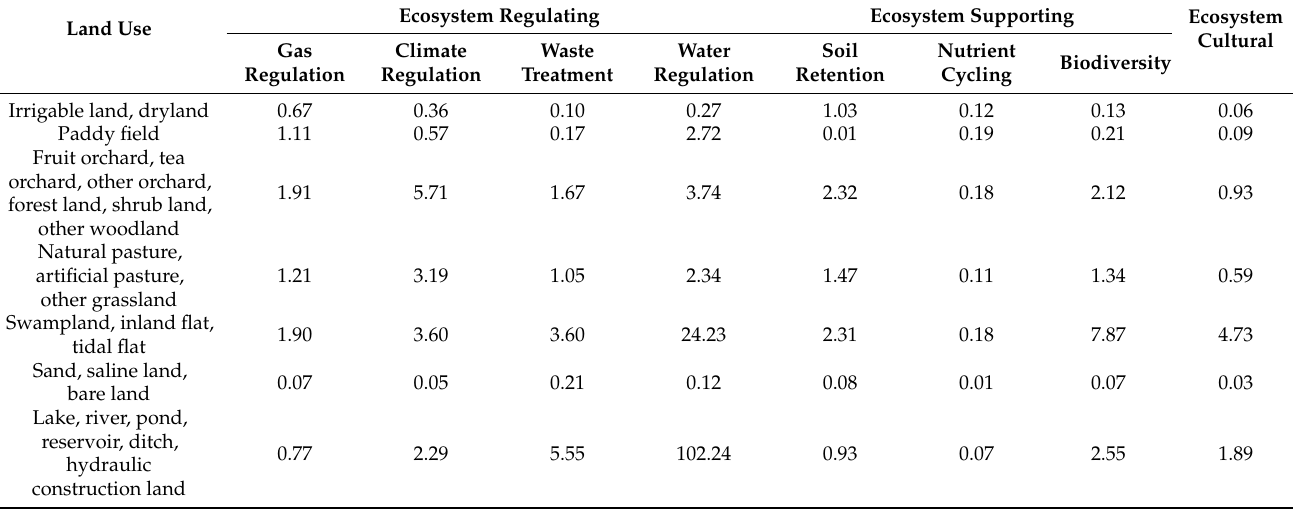
Table A1. The equivalent coefficients of ecosystem cultural and environmental functional